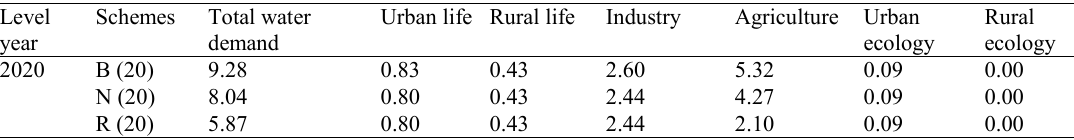
Table 3 Water demand prediction for schemes